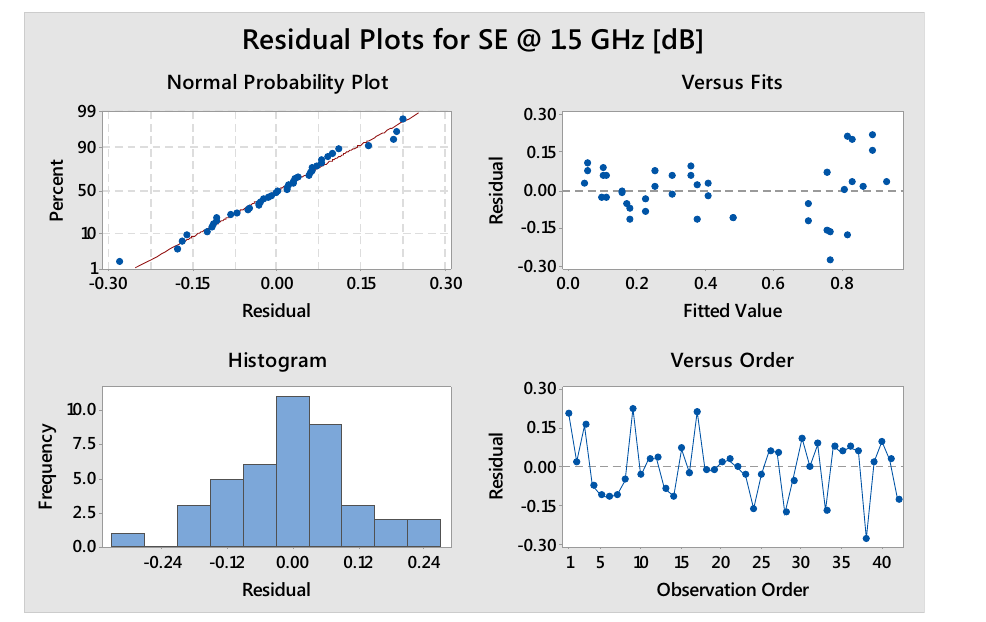
Figure 3. Residual plots for SE for process